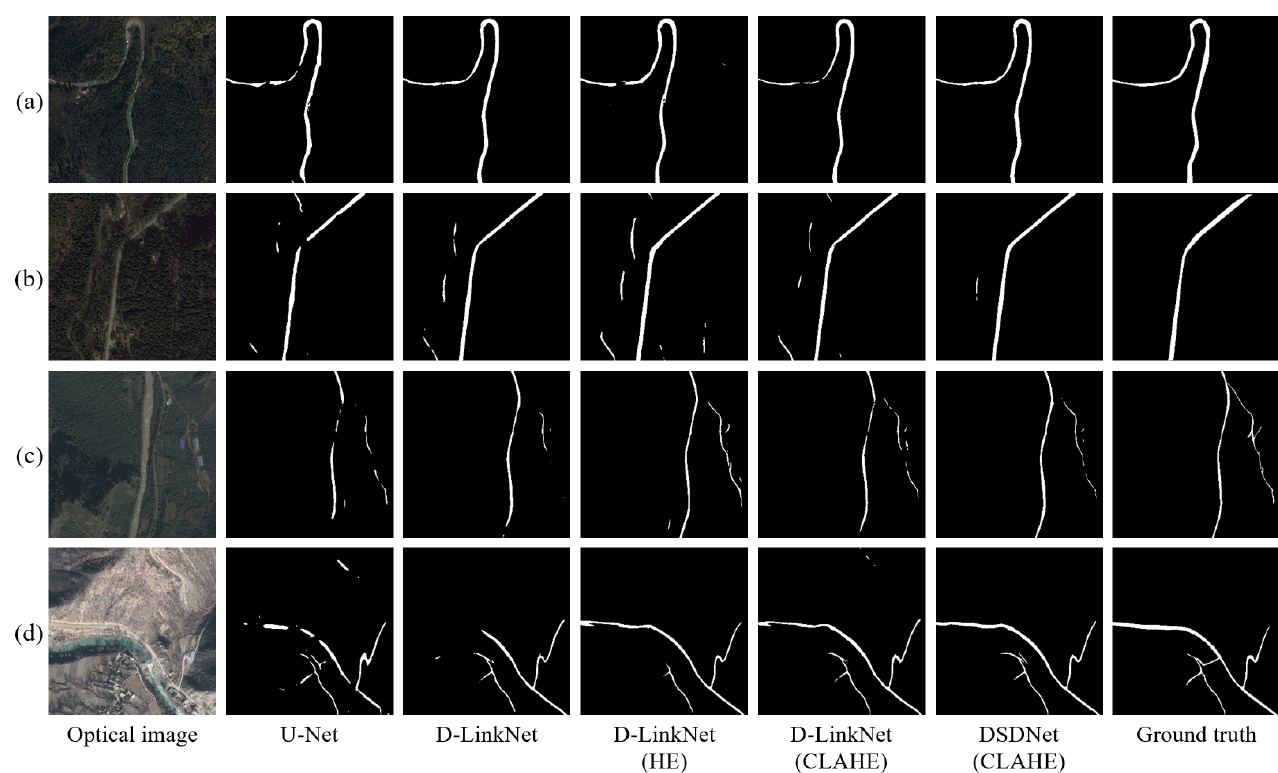
Figure 9. Diagram of the results from experimental samples: ( a – d ) shows the extraction of different samples.